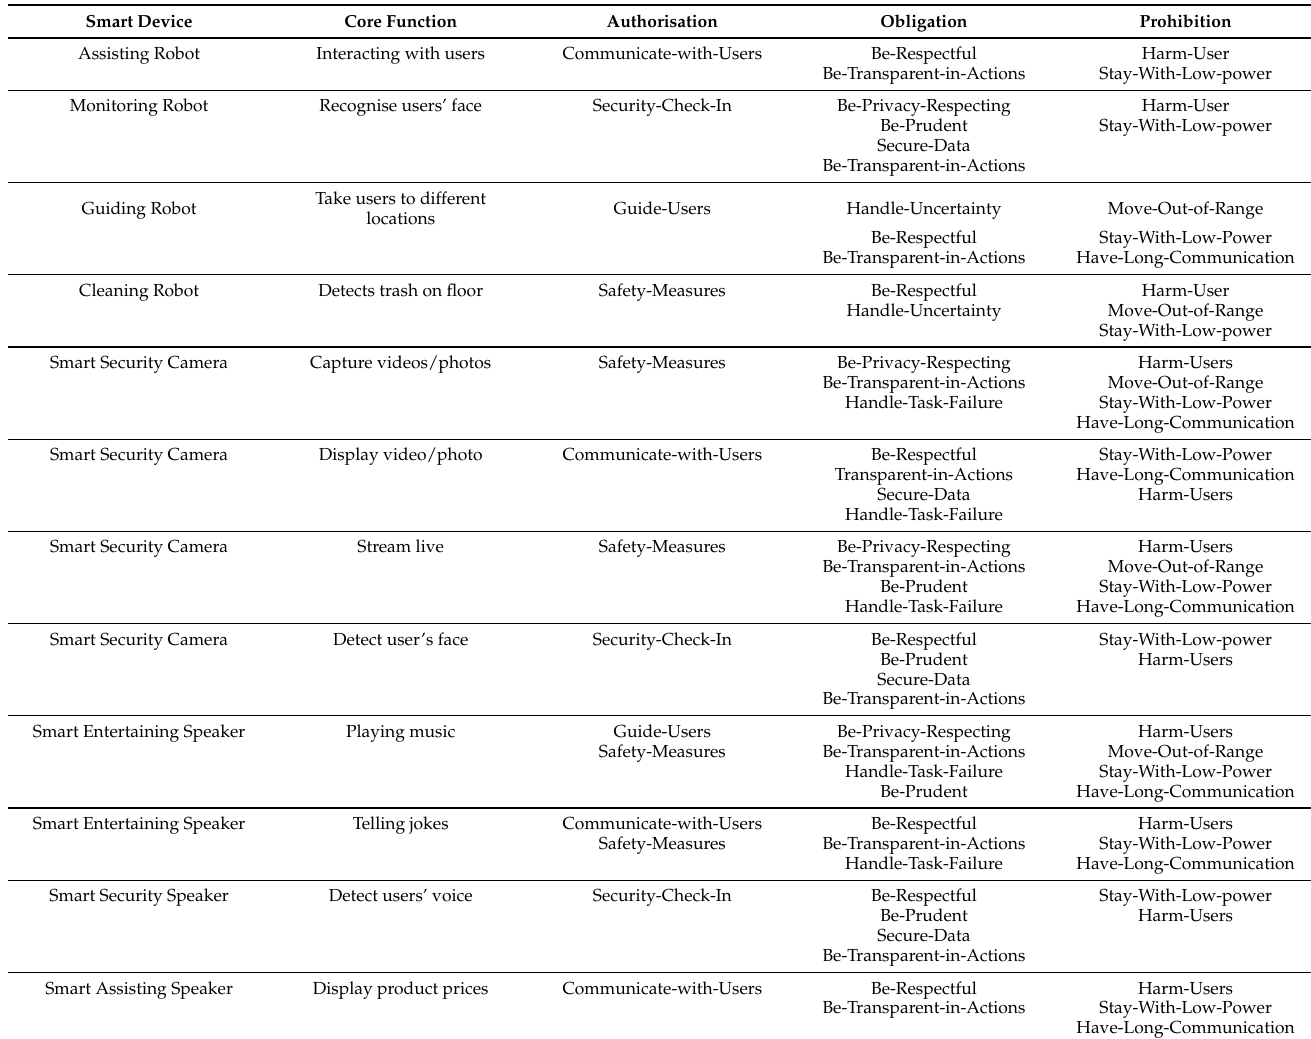
Table 2. Socio-ethical policies and core functions mapping—supermarket